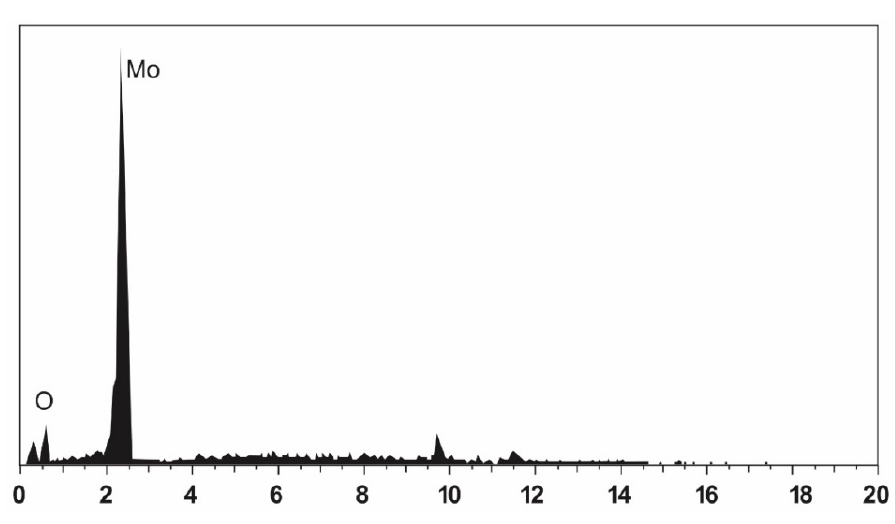
Figure 5. Energy-dispersive X-ray spectrum of MoO 3 nanobelts. Table 1. Elemental composition of MoO 3 nanobelts by EDS.